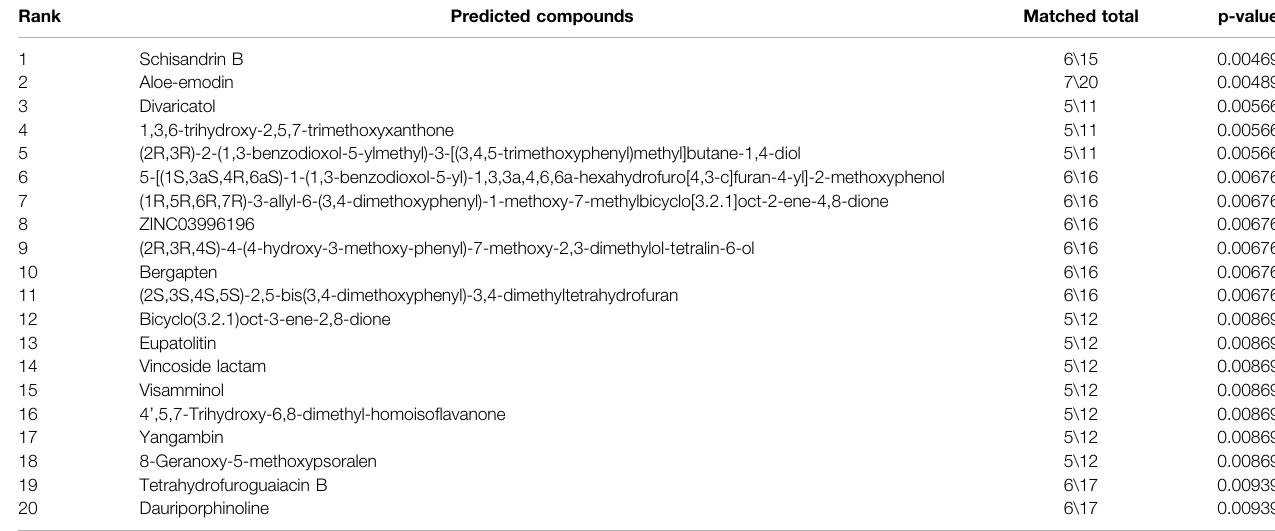
TABLE 2 | Network pharmacology predictions of mitochondria protective agents (Top 20) from natural products.